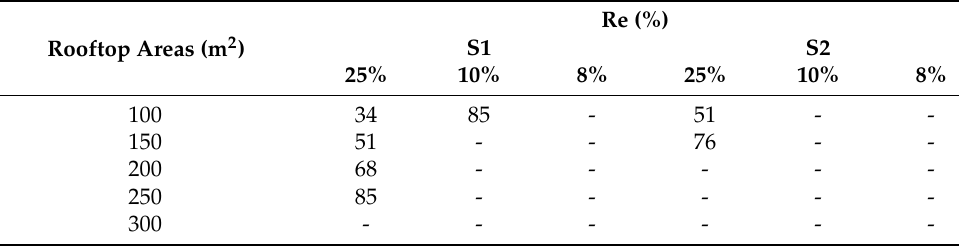
Table 6. Re values for selected DWD V values (percentages from the average DWD V ) in Jericho